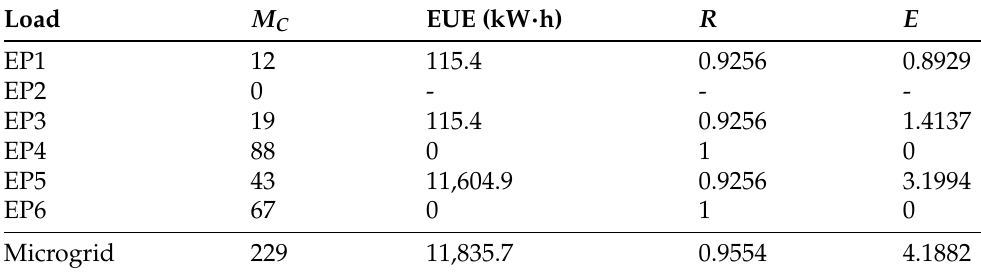
Figure 8. 72-h refueling disruption during islanded operation of alternate microgrid configuration. The current architecture is supplemented with a 19,000 m 2 PV array operating at 0.19 efficiency and a 330 kW/3.3 MW · h battery energy storage system (BESS). The same disruption scenario occurs from t = 160 to t = 231, preventing weekly scheduled refueling at t = 168. Critical loads with lower mission impact ( M C ) scores are shed during peak loading times (sloped sections), totaling to 11.8 MW · h of EUE. Table 4. Failure scenario summary with alternate microgrid configuration.